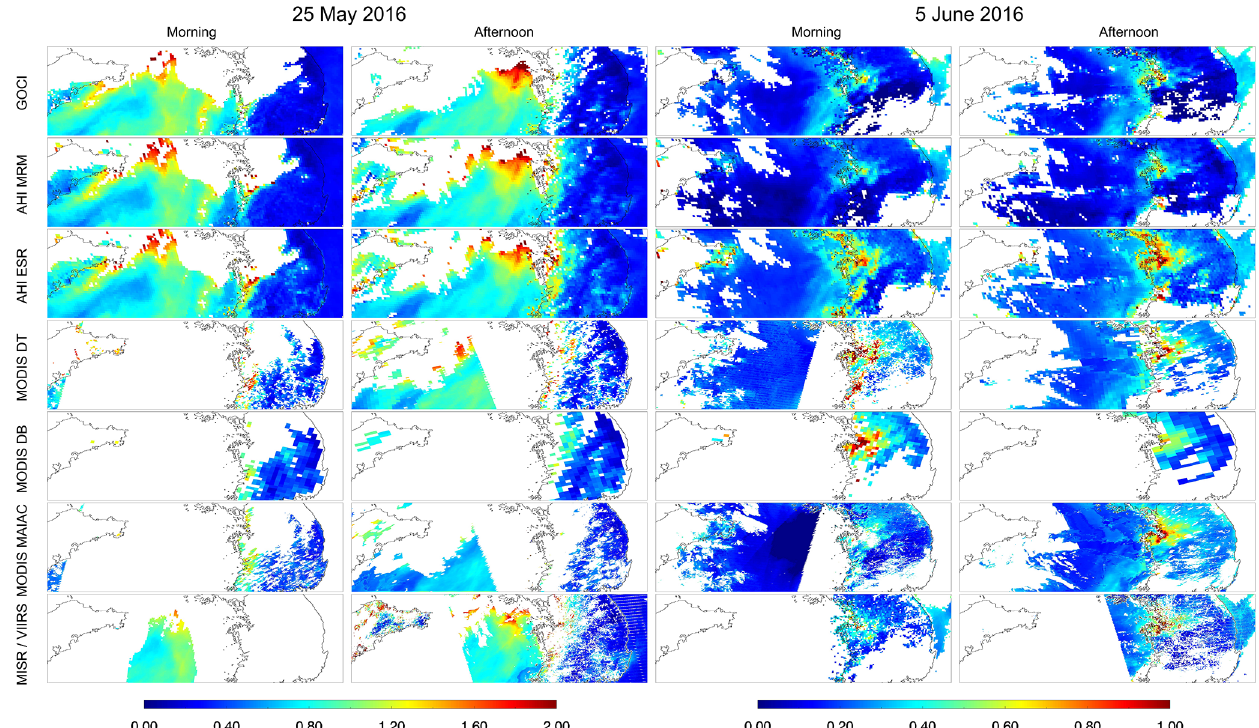
Figure 6. AOD distributions from GOCI, AHI MRM, AHI ESR, MODIS DT03K, MODIS DB, MODIS MAIAC, MISR, and VIIRS over the Yellow Sea and Korean Peninsula (35–38 ◦ N, 120–130 ◦ E) at 25 May and 5 June 2016. The local time of morning and afternoon measurements is identical with Fig.